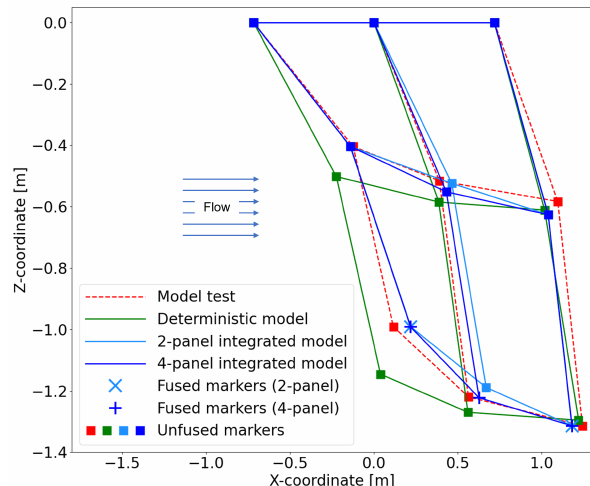
Figure 11: Cage deformation from the model test, de- terministic model, and integrated model (Case 1: flow speed = 0.33 m/s).